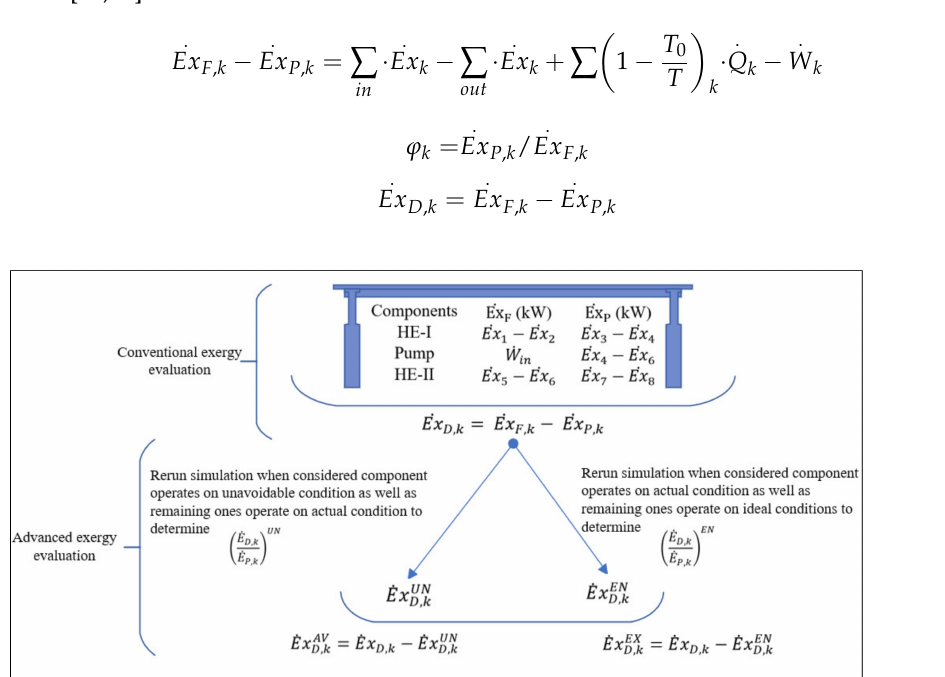
Figure 2. Flowsheet of the exergy assessment